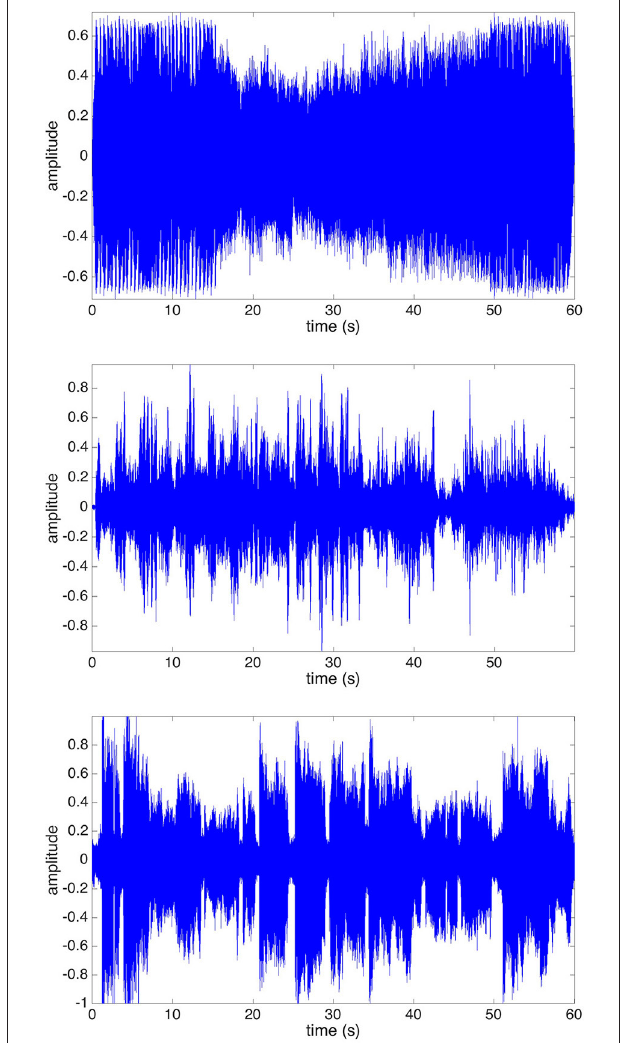
FIGURE 1 | Waveforms of the presented music stimuli: (Top) Electronic Dance Music (EDM); (Middle) Norwegian fiddle music (Telespringar); (Bottom) Indian Classical